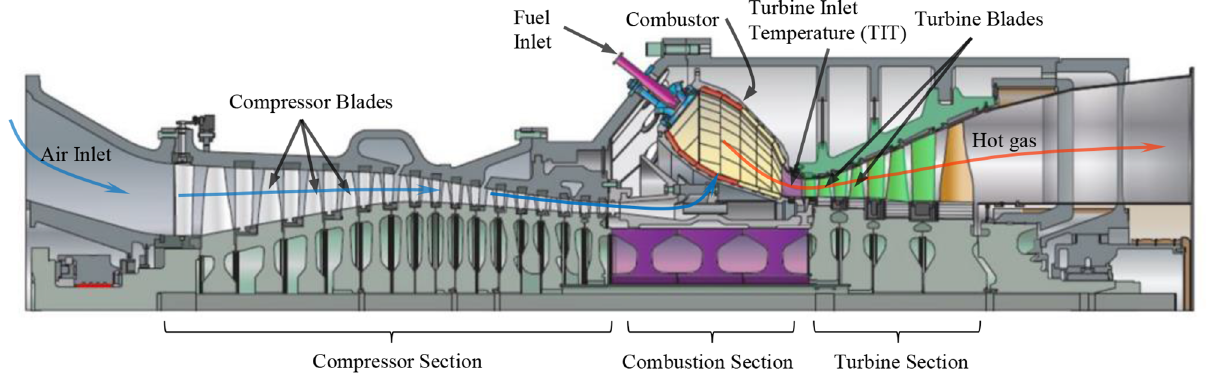
Fig. 1. A sectional view of the in-line axial gas turbine engine (courtesy